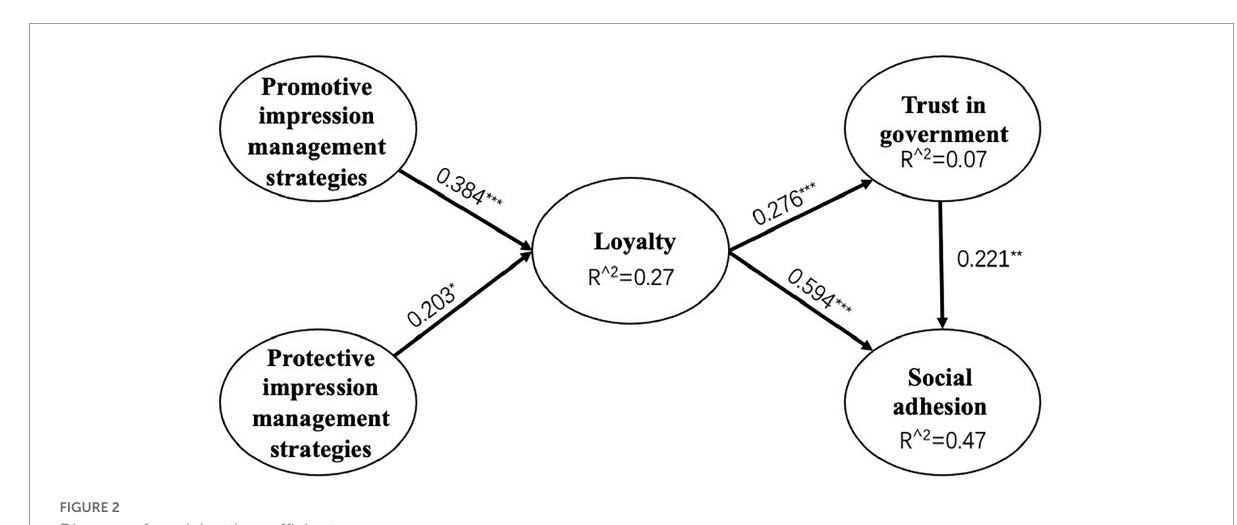
FIGURE2 Diagram of model path coefficients.